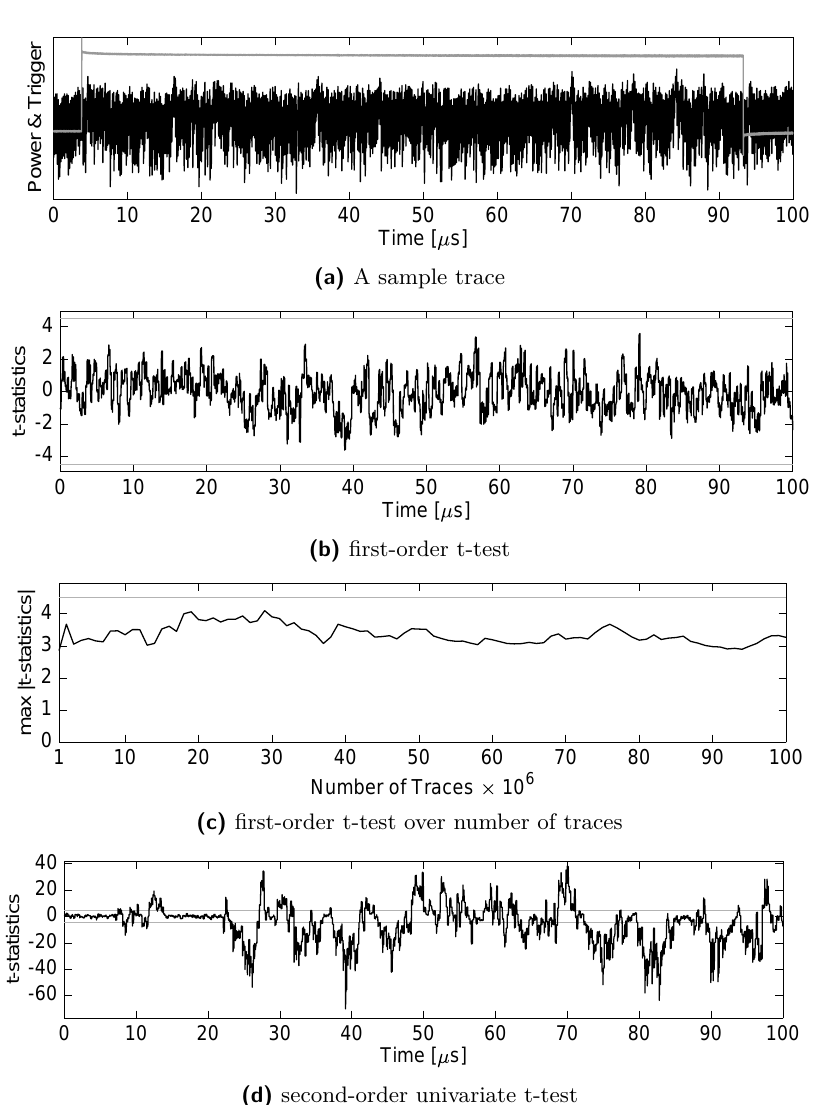
Figure 6: FPGA-based analysis of first-order round-based AES-128 encryption design, composed of COMAR gadgets, using 100 million